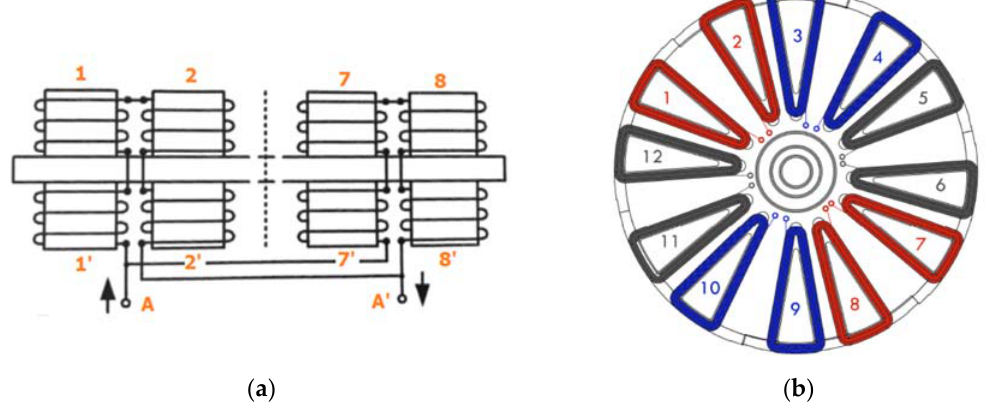
Figure 2. ( a ) schematic drawing of the coil’s arrangement of the two double electromagnets diametrically opposed (stator poles 1–2 and 7–8) [15], connected in parallel to form phase A. ( b ) upper view of the layout of the different phases (red: Phase A; blue: Phase B and black: Phase C).